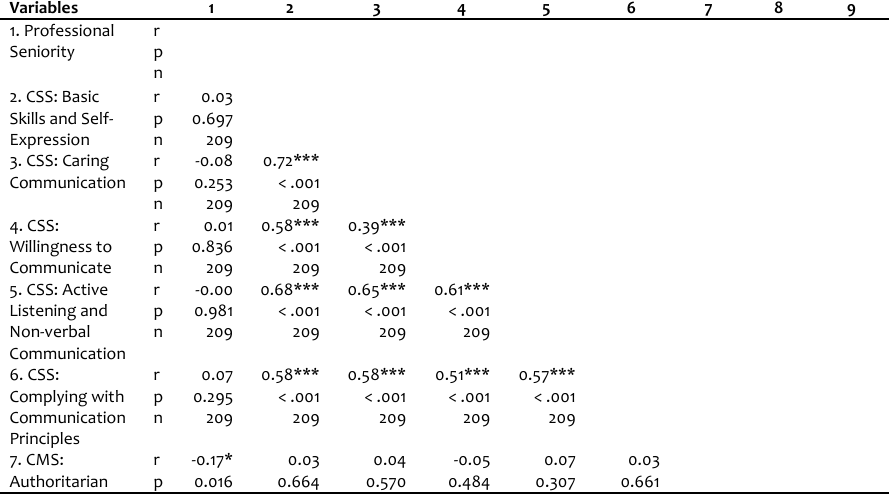
Table 3. Correlations between the quantitative predictors and outcome variable